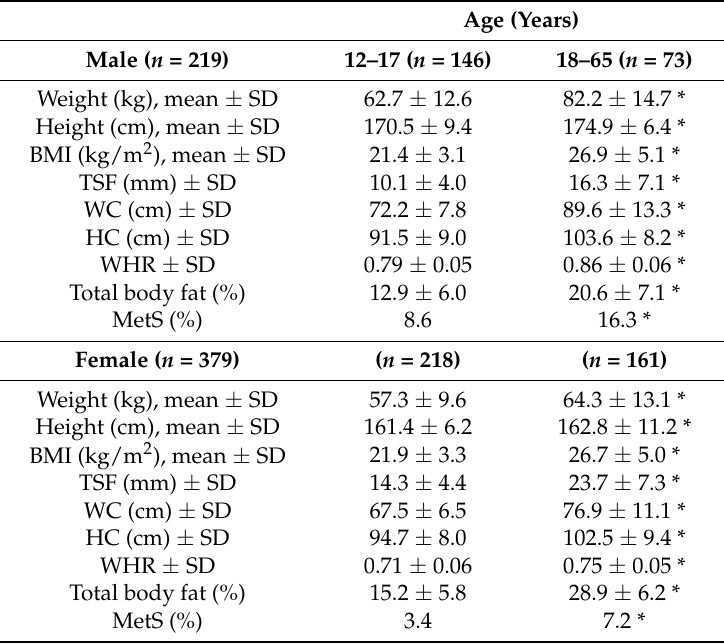
Table 1. General characteristics of male and female subjects studied.